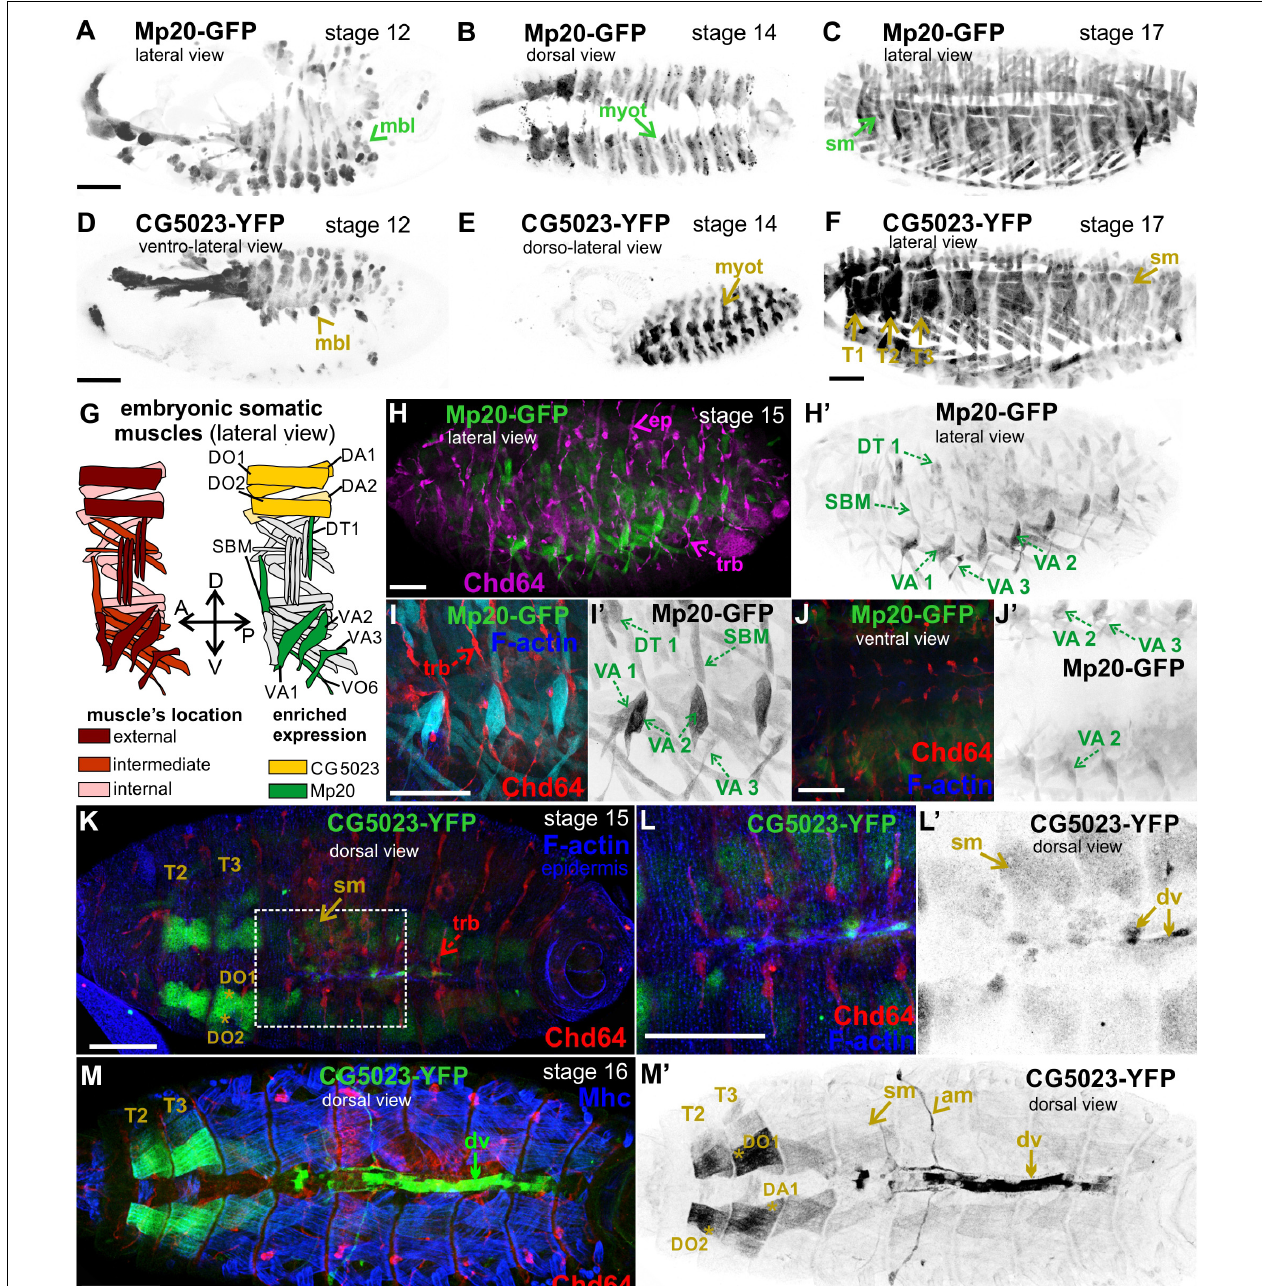
FIGURE 2 | Mp20 and CG5023 accumulation in the developing embryo. Confocal micrographs of embryos expressing fluorescently tagged transgelin proteins that reveal their endogenous tissue distribution at various developmental stages. (A–F) Living embryos expressing (A–C) Mp20-GFP and (D–F) CG5023-YFP. (A,D) Mp20 and CG5023 are expressed in all myoblasts at stage 12, (B,E) in all segmented organized myotubes at stage 14, and (C,F) in the entire somatic musculature at stage 17. (G) Schematic representation of the somatic muscle pattern (lateral view) in an abdominal segment of a late-stage embryo. (H–J) Stage 15 fixed embryos expressing Mp20-GFP protein, probed against Chd64 to verify their distinct patterns of expression in mesodermally and ectodermaly derived cells, respectively. Mp20-GFP specifically accumulates in DT1, VA1, VA2, VA3, and SBM abdominal muscles. (I,J) High magnification of embryonic muscles to visualize the muscle distribution and enrichment of Mp20 in muscles DT1, VA1–3, SBM, and DT1 and tracheal branches intense accumulation of Chd64 (red); F-actin was labeled with Alexa 647-phalloidin (blue). (K–M) Late-stage fixed embryos expressing CG5023-YFP, probed with antibodies against Chd64 (red) and muscle myosin (blue). (K,L) In stage 15 embryo, CG5023-YFP was significantly elevated in DO1/DA1 somatic muscles within T1/T2 thoracic segments and clearly apparent in the dorsal vessel. (M,M (cid:48) ) In stage 16 embryo, high levels of CG5023-YFP were detected in DO1/DA1 muscles within thoracic segments and also in the alary heart muscles along with elevated accumulation in the dorsal vessel. Each image is representative of at least five different imaged embryos of the same genotype and markers used. mbl, myoblast; myot, myotube; sm, somatic muscles; T1–T3, thoracic segments 1, 2, 3; ep, epidermis; trb, tracheal branch; DT, dorsal transverse; SBM, segment border; DA, dorsal acute; VA, ventral acute; VO, ventral oblique; dv, dorsal vessel; am, alary muscles. Scale bars: 50 µ m in all panels.